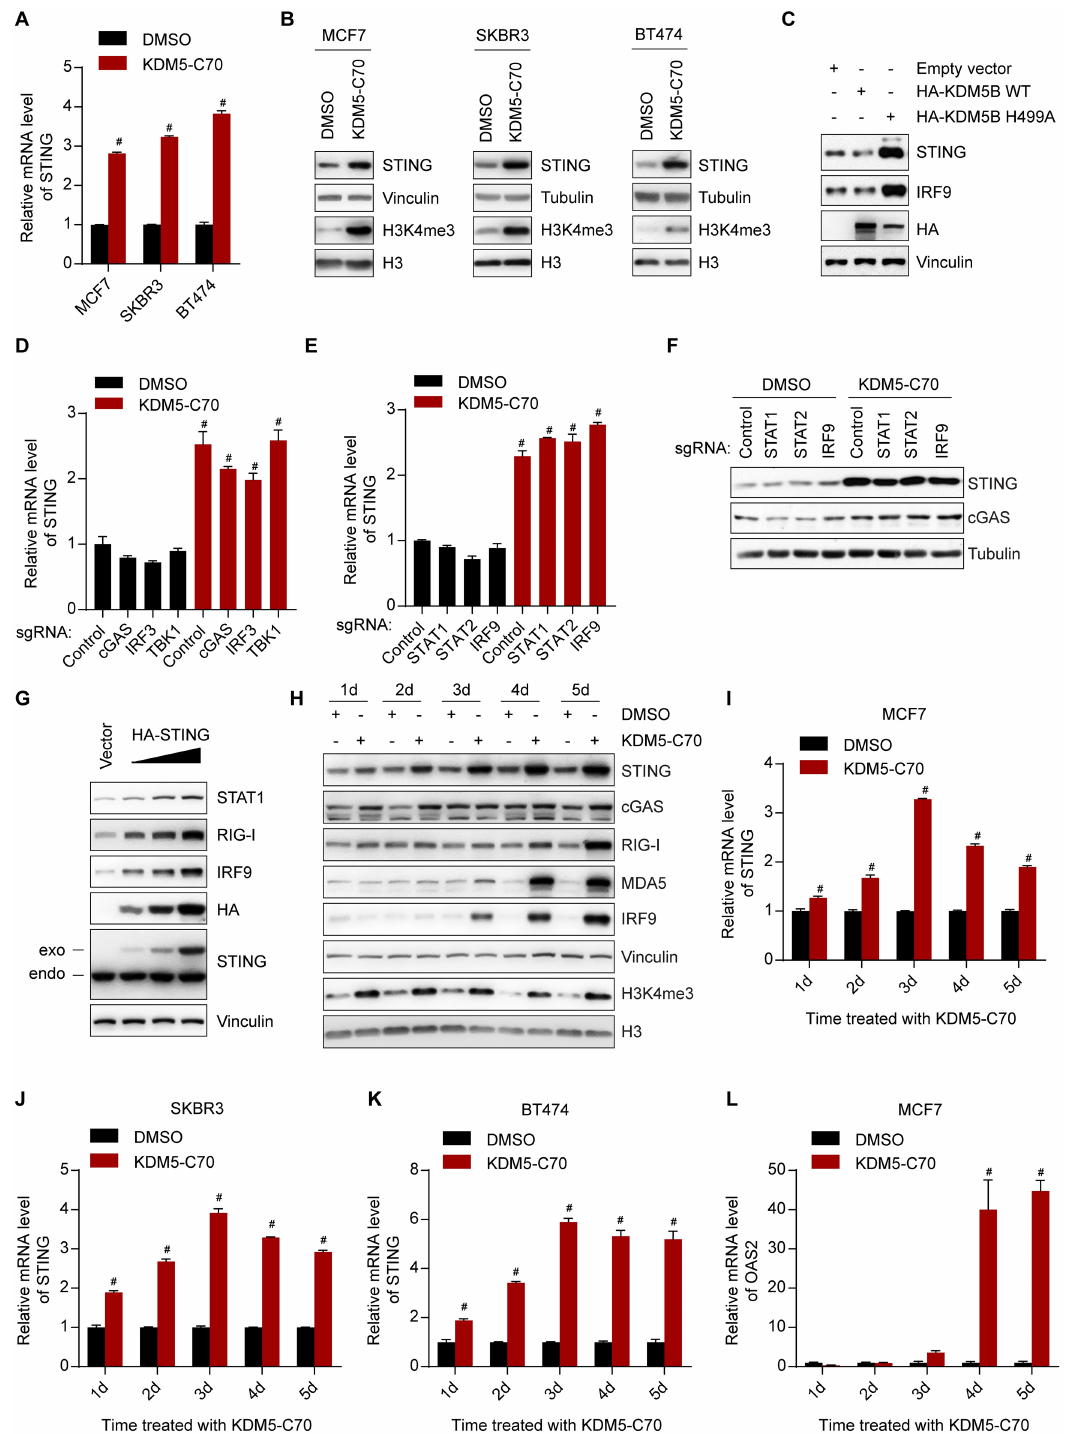
Fig 4. Inhibition of KDM5 demethylases induces STING expression. (A, B) RT-qPCR analysis (panel A) or western blot (panel B) analysis of the indicated cells after treatment with DMSO or 1 μM KDM5-C70 for 3 days. (C) Western blot analysis of MCF7 cells transfected with the indicated expressing plasmids. (D–F) RT-qPCR (panel D and E) or western blot (panel F) analyses of MCF7 cells with knockout of indicated genes after treatment with DMSO or 1 μM KDM5-C70 for 6 days. (G) Western blot analysis of MCF7 cells 2 days after transfection with different amounts of the indicated plasmid. (H–L) Western blot (panel H) or RT-qPCR (panel I–L) analysis of MCF7, SKBR3, or BT474 cells after treatment with DMSO or 1 μM KDM5-C70 for the indicated length